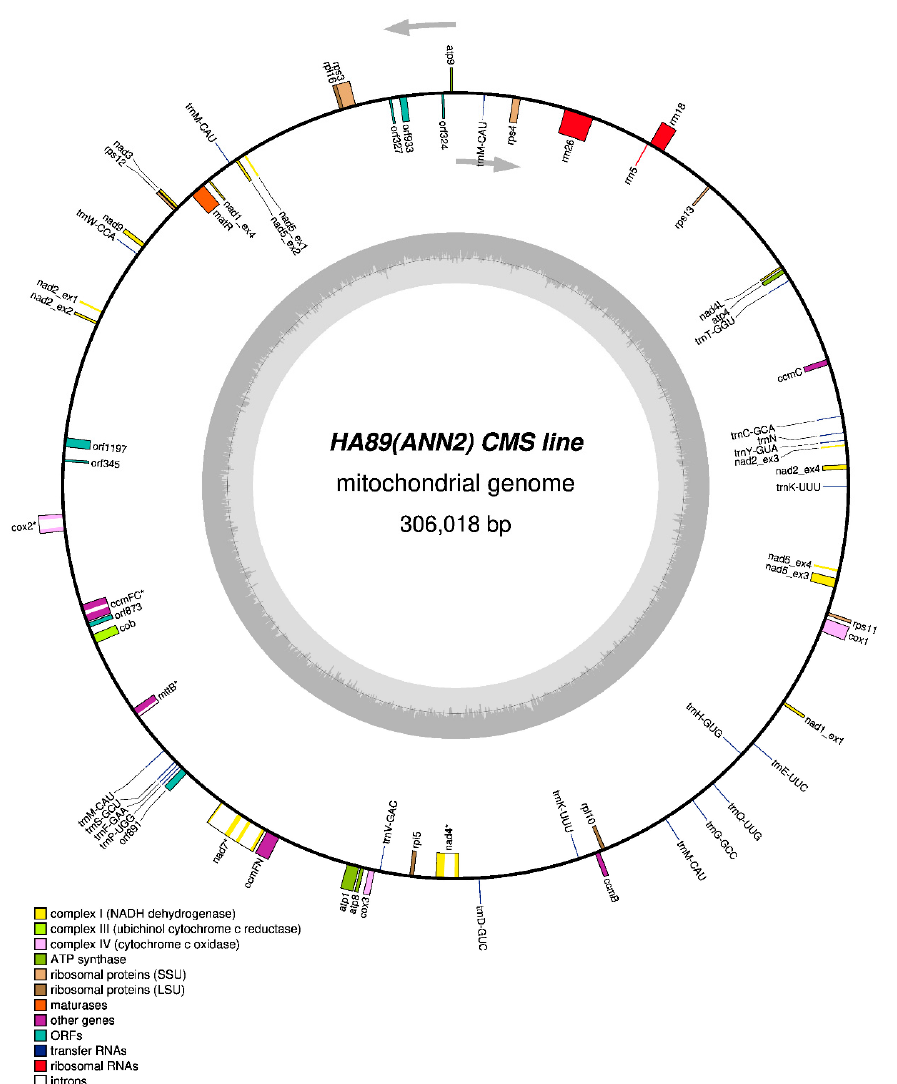
Figure 1. Mitochondrial genome map of HA89(ANN2) cytoplasmic male sterility (CMS) line of sunflower. Intron containing genes are marked by an asterisk (*) symbol. Trans-spliced genes are presented as the compilation of exons